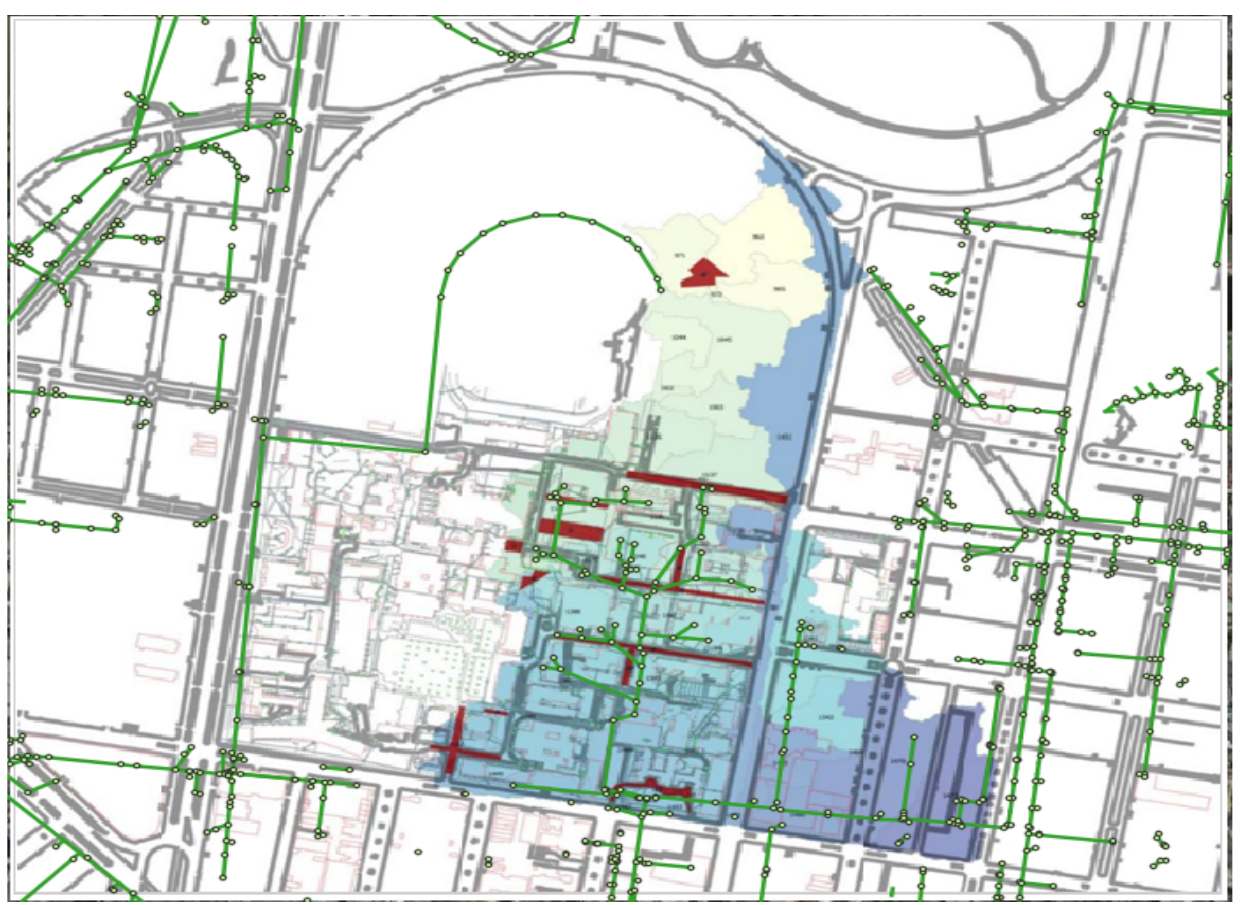
Figure 3. Locations identified for implementation of permeable pavements (areas marked in red). The green lines indicate drainage network.